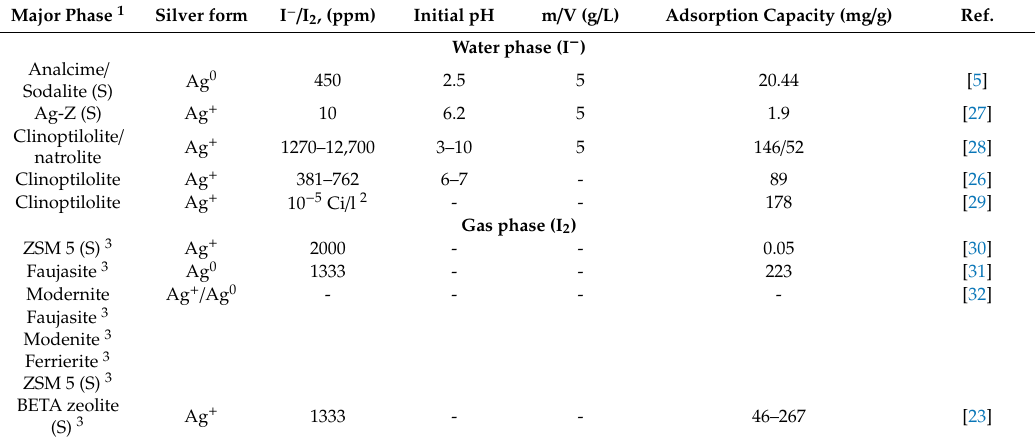
Table 1. Natural and synthetic silver modified zeolites applied for removal of iodide / CH 3 I from water and